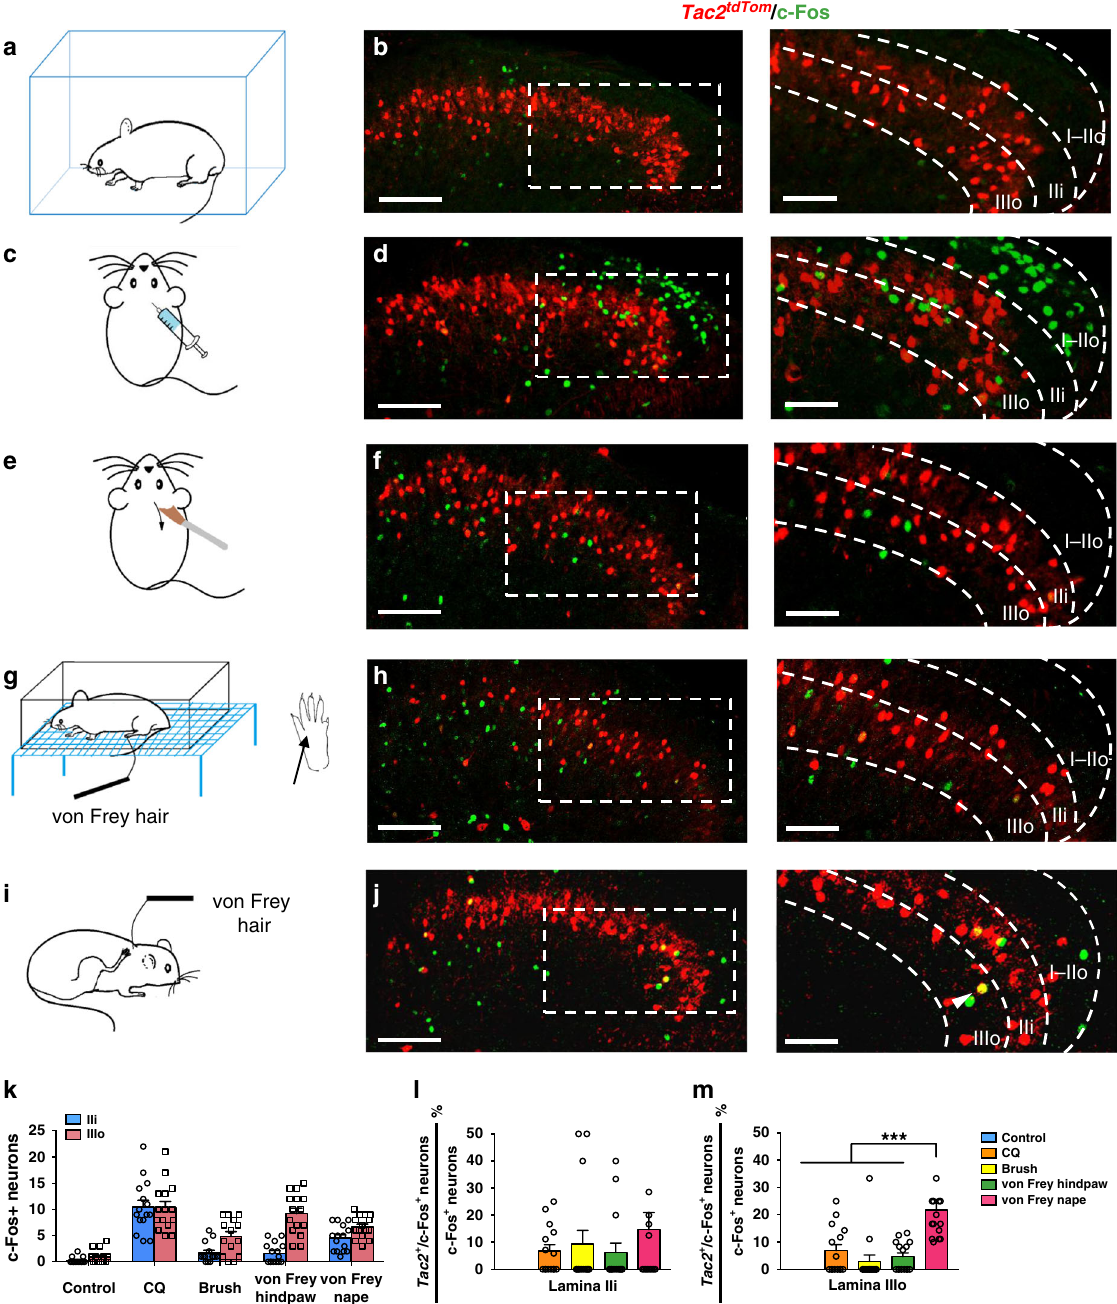
Fig. 1 Tac2 Cre neurons in the spinal cord are activated by mechanical itch stimulation. a , c , e , g , i Schematic of mice in free ambulating state ( a ), i.d. CQ injection ( c ), soft brushing ( e ), von Frey hair applied to the hindpaw ( g ), von Frey hair applied to the hairy skin ( i ). b , d , f , h , j Representative images of c- Fos expression (green) in the spinal cord of Tac2 tdTom (red) mice corresponding to a , c , e , g , i , respectively. Right: higher magni fi cation of the boxed area. Scale bars, 100 μ m (left); 50 μ m (right). n = 3 mice per group. k Comparison of the total number of c-Fos positive neurons in laminae IIi and IIIo under different conditions. n = 15 sections from three mice per group. l , m Comparison of the percentage of Tac2 tdTom and c-Fos double positive neurons in c-Fos positive neurons in lamina IIi ( l ) and IIIo ( m ) under different conditions. n = 15 sections from three mice per group. one-way ANOVA with Tukey post-hoc , *** p = 0.0001. All data are presented as mean ± s.e.m. and error bars represent s.e.m. Source data are provided as a Source Data fi neurons band are considered as lamina IIIo neurons. This lamina IIIo is phasic-bursting (80.6%, 29 of 36) (Fig. 2e, f), enabled us to identify and record Tac2 tdTom neurons in these two whereas the rest comprising single spiking (2.8%, 1/36), delayed fi ring (5.6%, 2 of 36), and initial bursting (11.1%, 4 of 36) regions discretely (Fig. 2a, d). Tac2 tdTom neurons in lamina IIi displayed four distinct fi ring patterns: delayed fi ring (25.7%, 19 of (Fig. 2f). The observation that a vast majority of lamina IIIo Tac2 74), initial fi ring (10.8%, 8 of 74), tonic fi ring (31.1%, 23 of 74) neurons show the same fi ring pattern is highly unusual, given the and phasic-bursting pattern (24.0%, 19 of 74) (Fig. 2b, c). More heterogeneity of the fi ring patterns for lamina III interneurons as strikingly, the dominating fi ring pattern of Tac2 tdTom neurons in shown previously 7,21 .